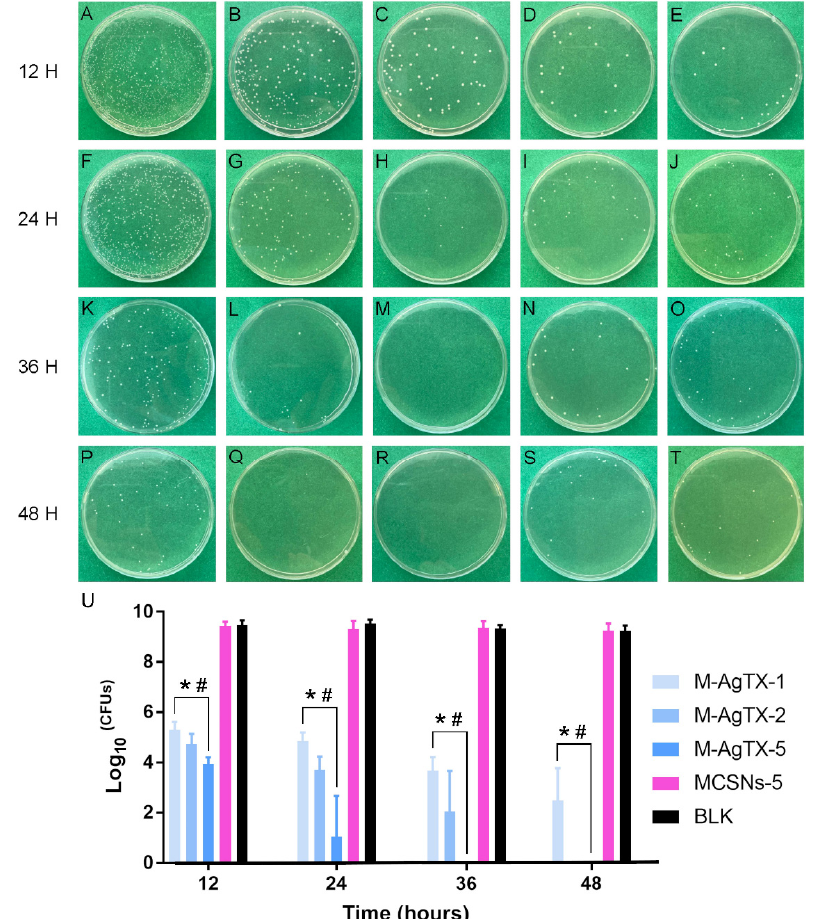
Figure 6. Anti-bacterial effects of different concentrations of materials against planktonic E. faecalis at different time intervals. ( A – C , F – H , K – M , P – R ) Representative images of CFUs of 1, 2, 5 mg/mL M-AgTX groups at 12, 24, 36, 48 h; ( D , I , N , S ) Representative images of CFUs of 5 mg/mL MCSNs group at 12, 24, 36, 48 h after 10 6 times dilution; ( E , J , O , T ) Representative images of CFUs of BLK at 12, 24, 36, 48 h after 10 6 times dilution; ( U ) Log 10 (CFUs) of groups. (BLK: blank control group; M-AgTX-1, M-AgTX-2, M-AgTX-5: 1, 2, 5 mg/mL M-AgTX groups; MCSNs-5: 5 mg/mL MCSNs group; *, #: significant difference when compared with MCSNs-5 group and BLK group, respectively, p < 0.05.).